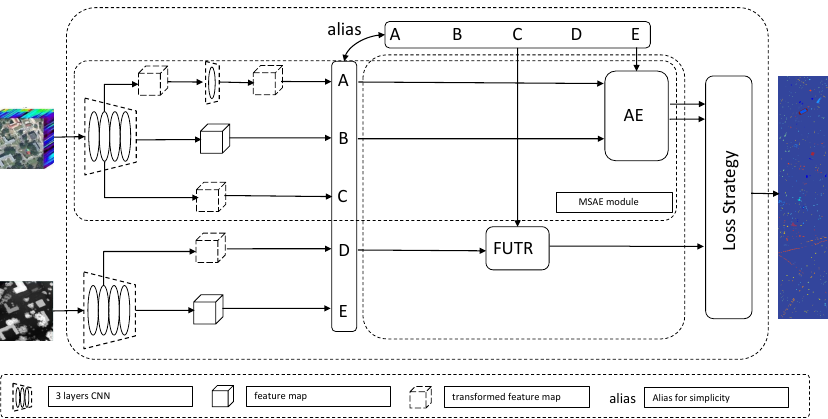
Figure 1. Structure of the network. In order to avoid cross-connection, we use the matrix form to represent the data flow. It is mainly composed of three parts: MSAE, FUTR, and loss strategy (MOM). The feature map extraction part is appropriately simplified in the figure, and the number of ellipses represents the number of convolutions. For ease of presentation, the five inputs of A-E are set with five more identical aliases. In addition, before extracting features from HSI, PCA technology is used to reduce the channel dimension of HSI. For brevity, the original input size in the above figure has been reduced, and the final output represents the true